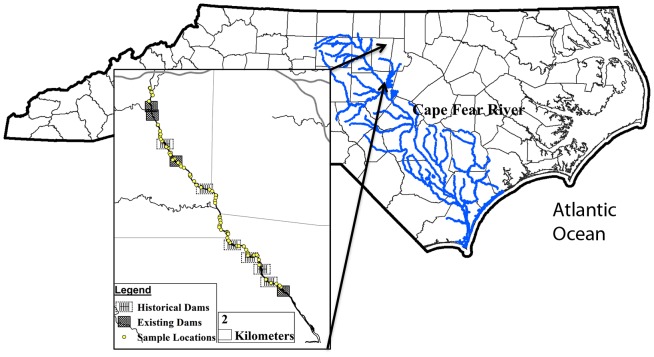
Location of the study area on the Haw River.